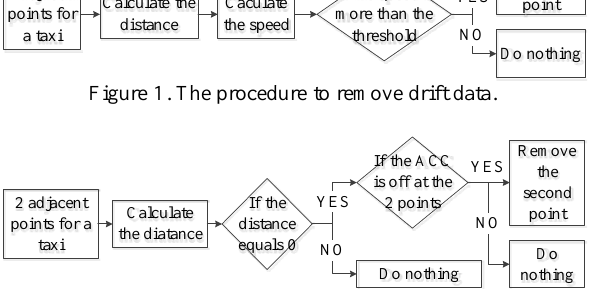
Figure 2. The procedure to remove redundant data.